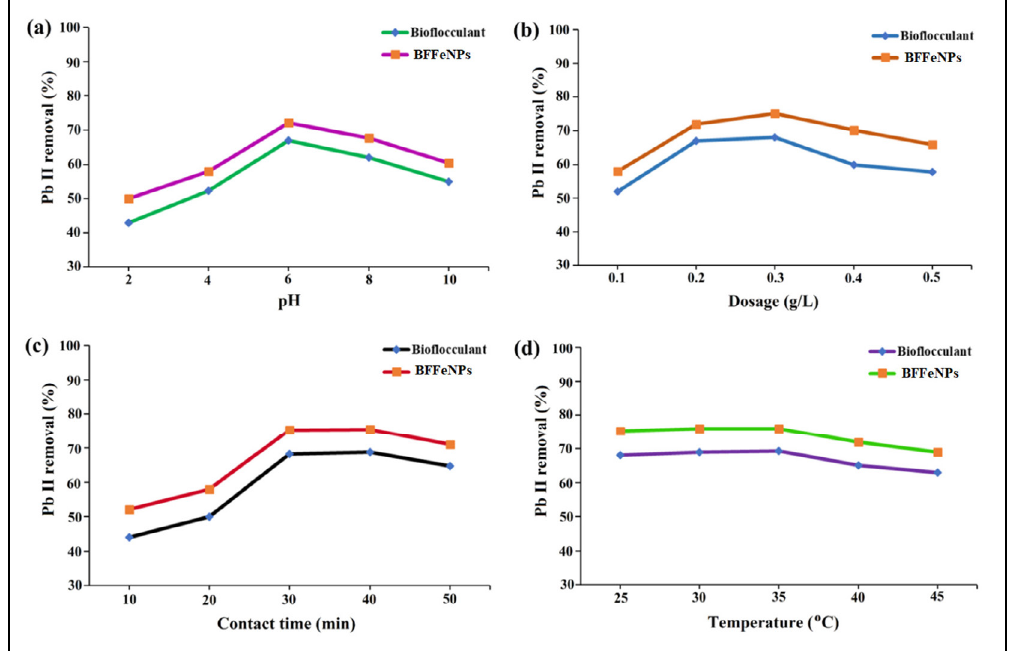
Fig. 4. Effect of parameters on Pb(II) removal from real wastewater using purified Okra bioflocculant and BFFeNPs (a) Effect of pH, (b) Effect of dosage, (c) Effect of contact time, and (d) Effect of